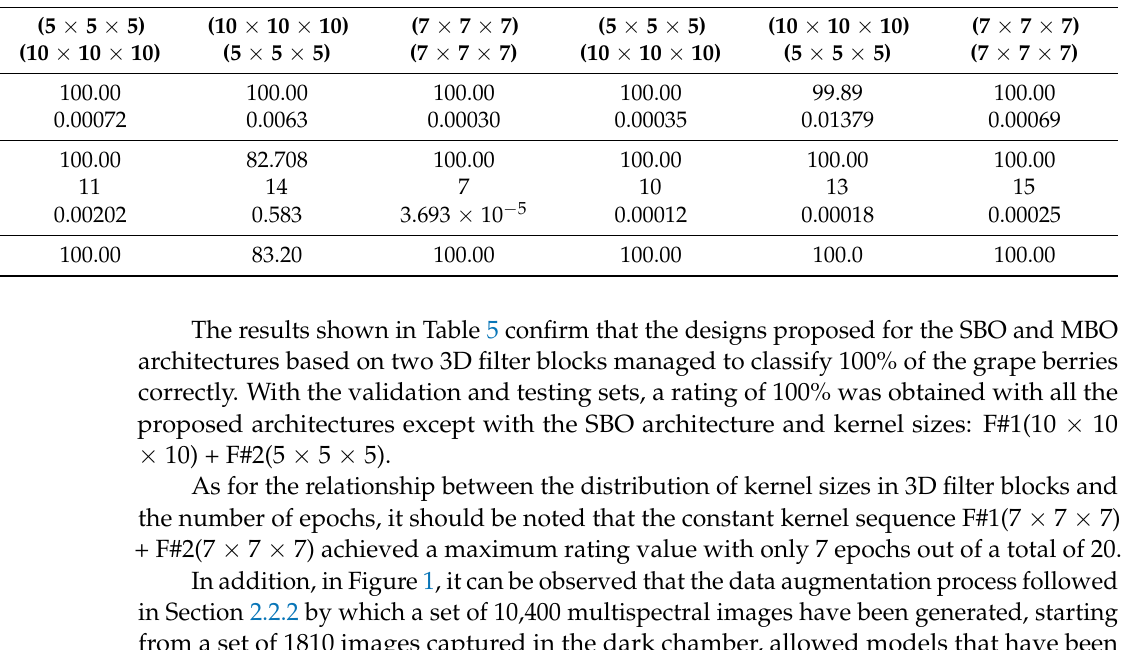
Table 5. Training, validation and test accuracy and loss function error for three different filter sequences of SBO and MBO architectures. Architecture SBO Kernel Sizes MBO Kernel